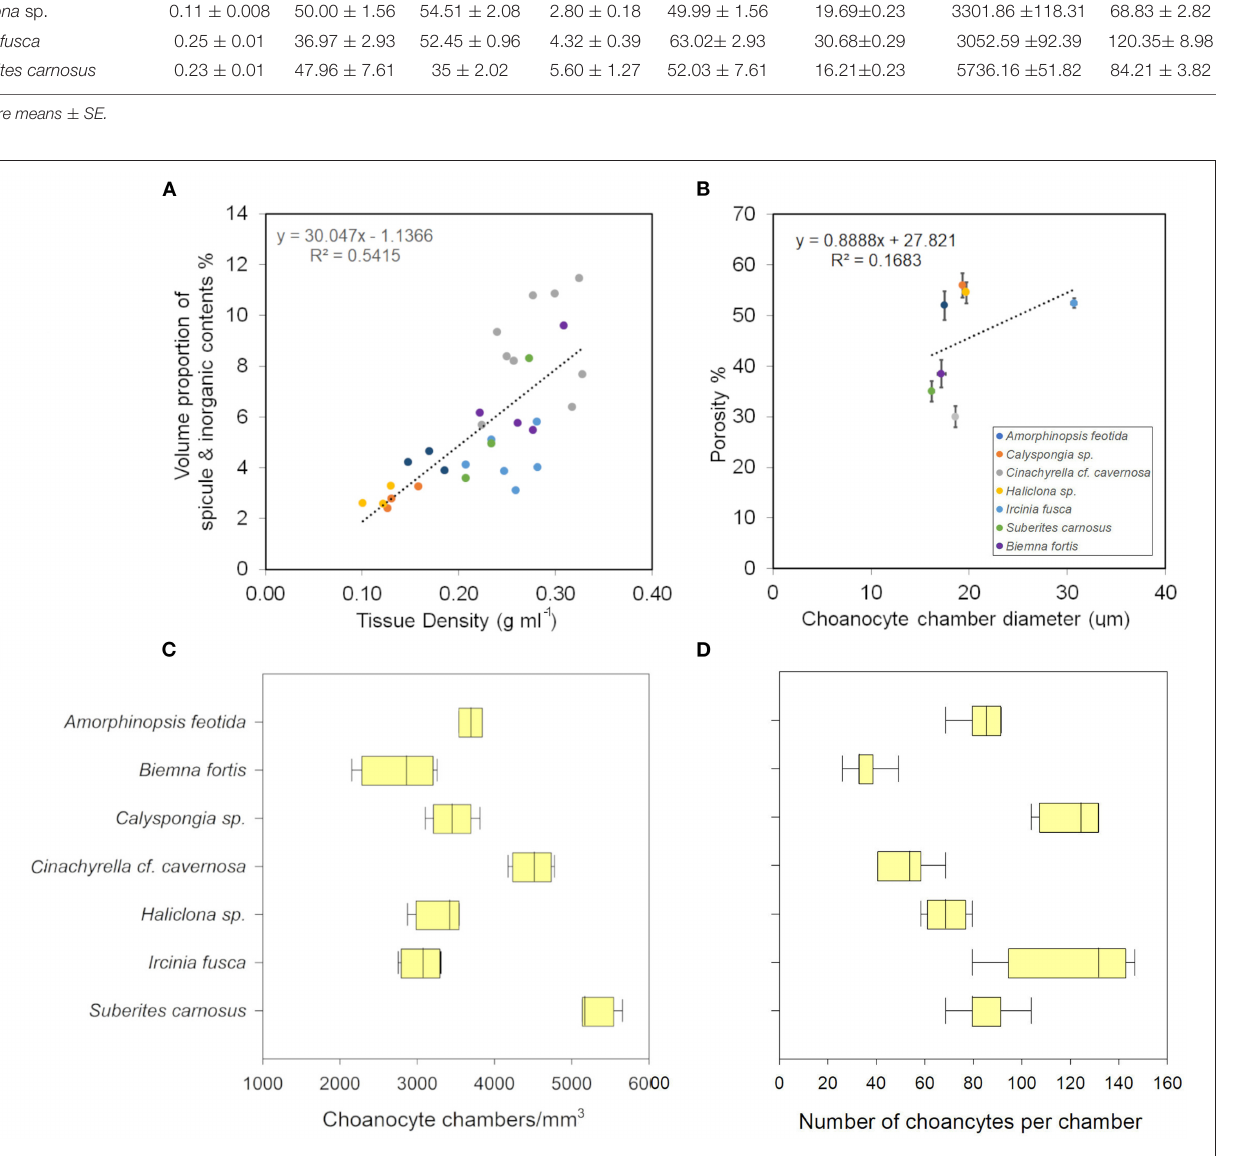
= 0.73, n = 31, p < 0.001). This suggests that the spicules constitute a major portion of sponge dry weight and also sponge